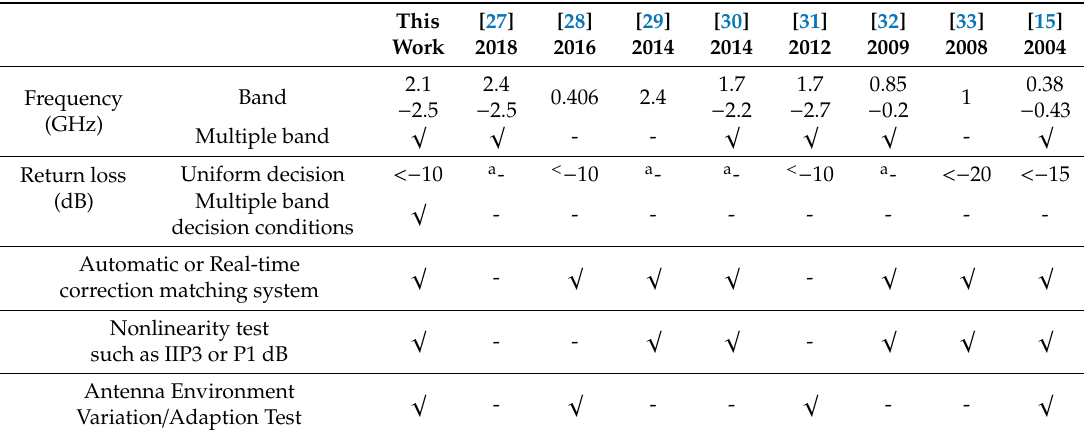
Table 2. Comparison for the selected relevant